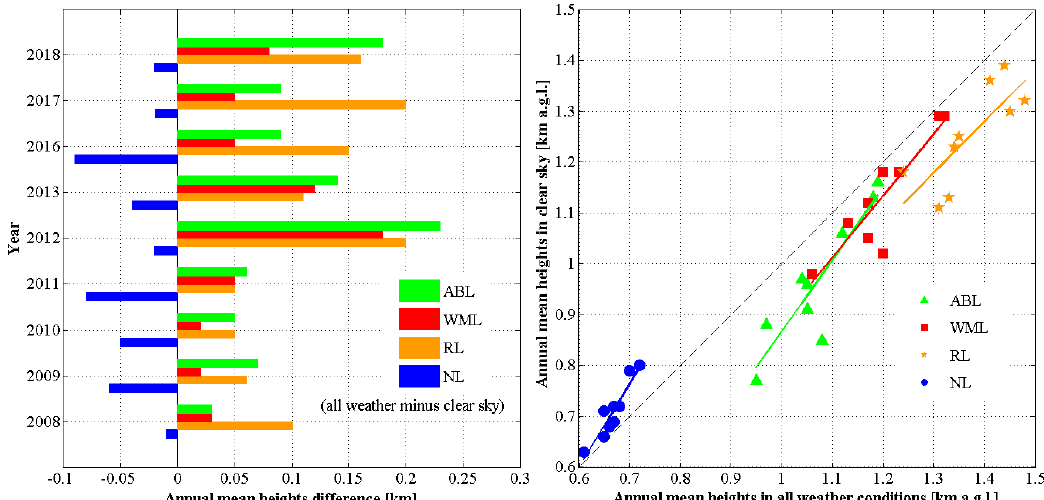
Figure 11. The difference of the annual mean boundary layer heights obtained in all-weather and clear-sky conditions (left subfigure). The comparisons of the mean annual boundary layer heights in both conditions (right subfigure). Notation: the atmospheric boundary layer (ABL), the well-mixed layer (WML), the nocturnal layer (NL), and the residual layer (RL). Data derived by the CHM15k ceilometer and the PollyXT lidar over Warsaw within the period of 2008 to 2018. A lack of data points due to the underrepresentation of the annual mean for 2014 and 2015. Merging and homogenization were applied to lidar data from November 2013 to December 2018.